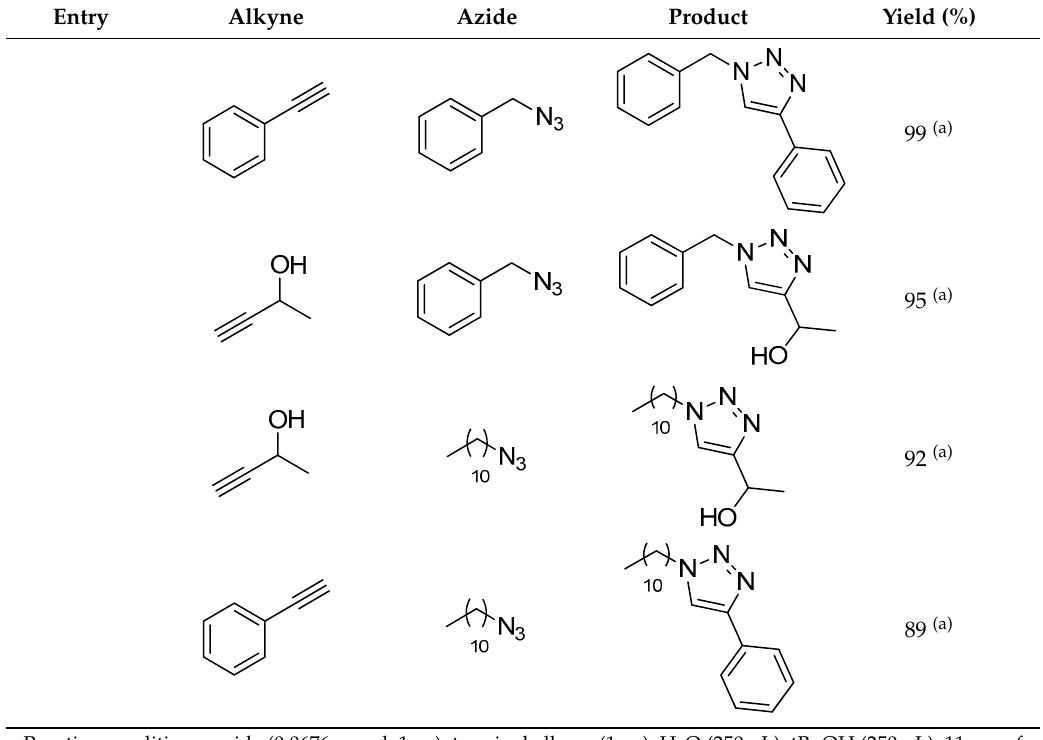
Table 4. Synthetic results of conventional Cu-supported catalyst.